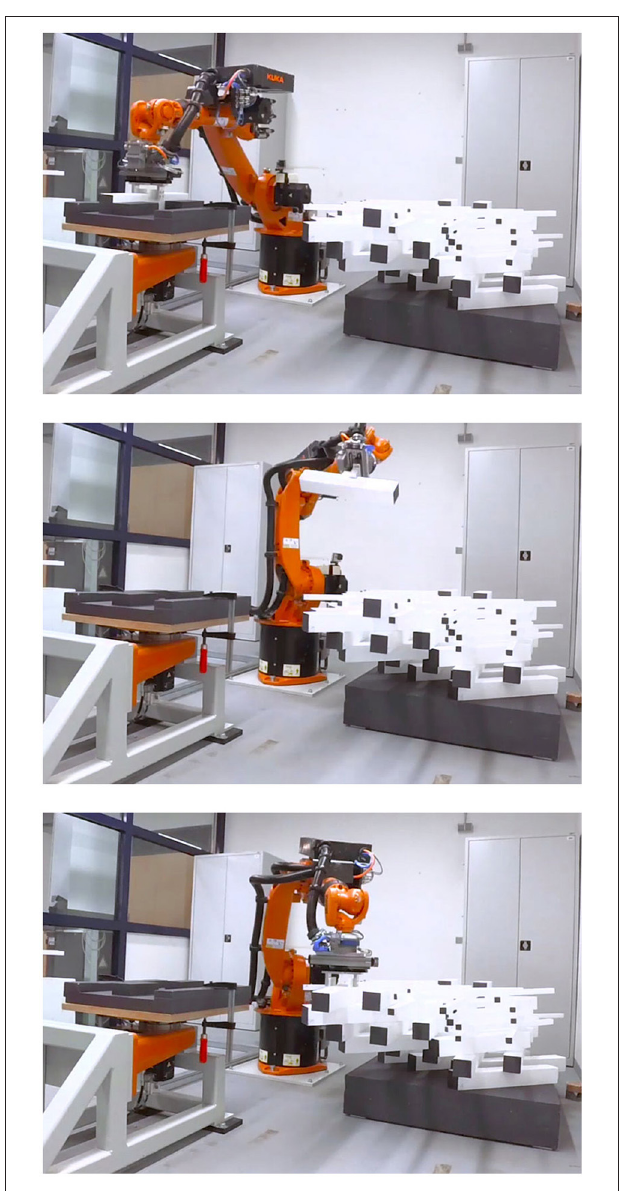
FIGURE 4 | Working path for stacking involved movement sequences such as picking, transporting, and placing.